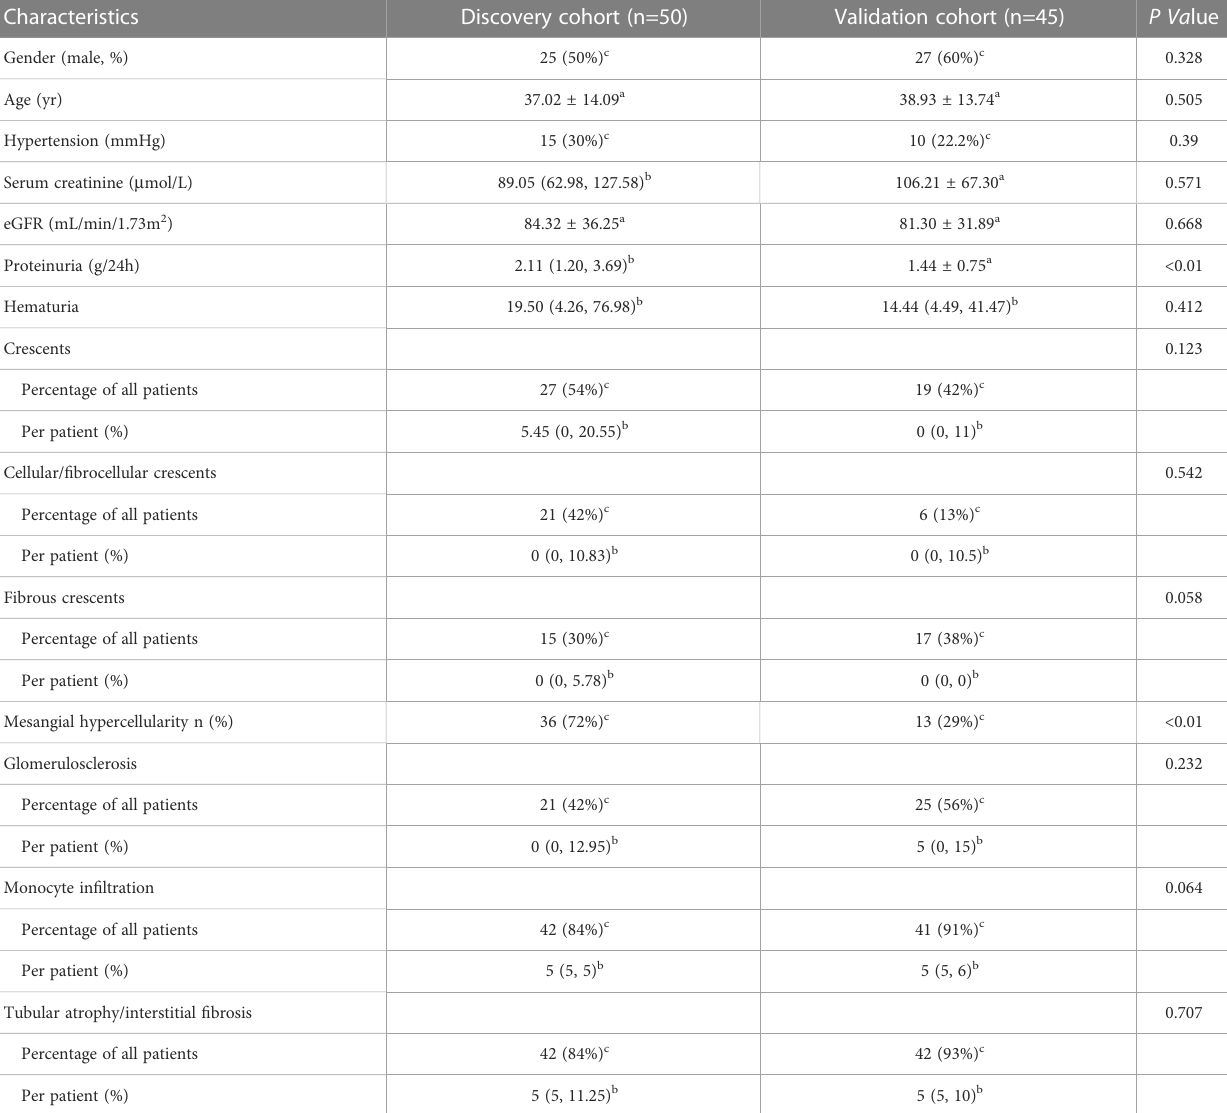
TABLE 1 Baseline demographic, clinical, and pathological characteristics of patients with